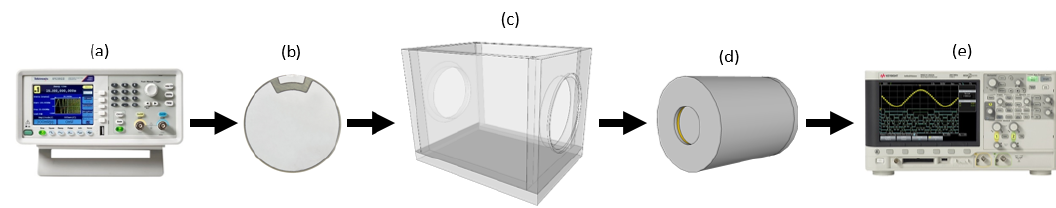
Figure 1. Experiments configuration